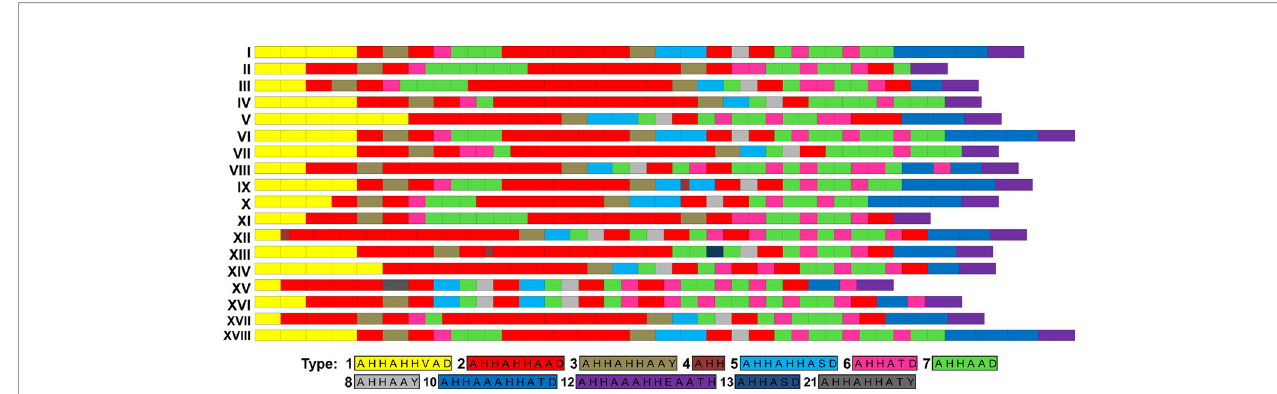
FIGURE 4 | Patterns of PfHRP2 sequences of P. falciparum isolates from South America. Amino acid repeat types were identi fi ed as previously described (Baker et al., 2005; Baker et al., 2010). PfHRP2 sequence patterns I to X were identi fi ed in isolates sequenced in this study.